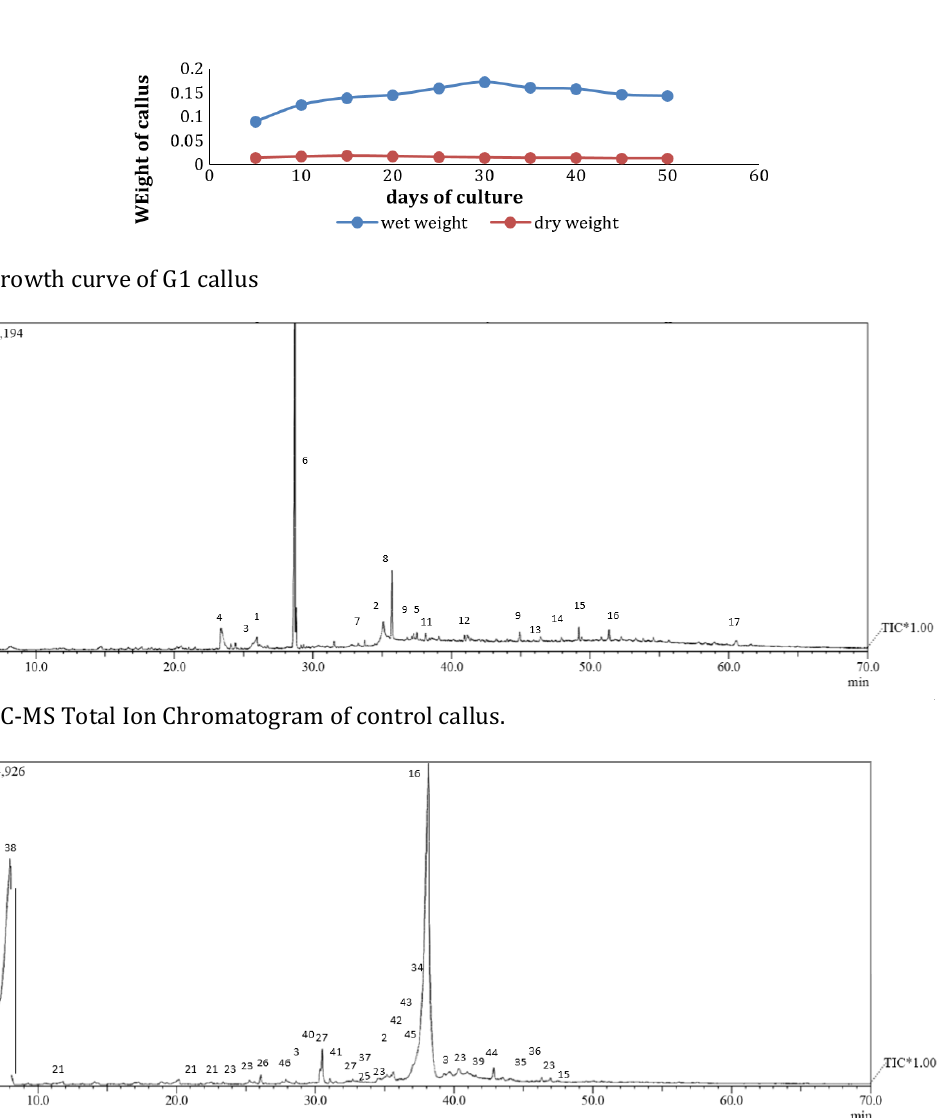
Figure 3. GC-MS Total Ion Chromatogram of callus maintained in 4°C without alginate encapsulation